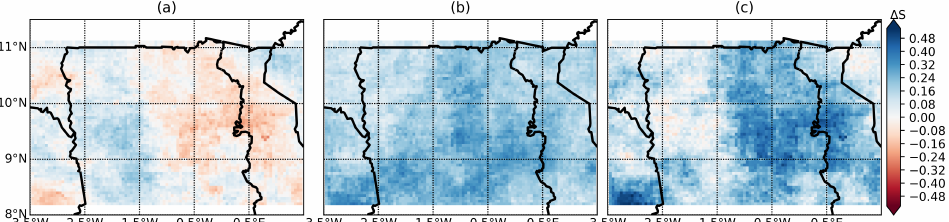
Figure 5. Spatial-temporal trends (days/year) of rainfall onsets ( a ), cessation dates ( b ), and length of growing season ( c ) over Northern Ghana for 39 years period (1981–2019). The blue and red tones represent grid cells with early (shorter) and late (longer) trends,